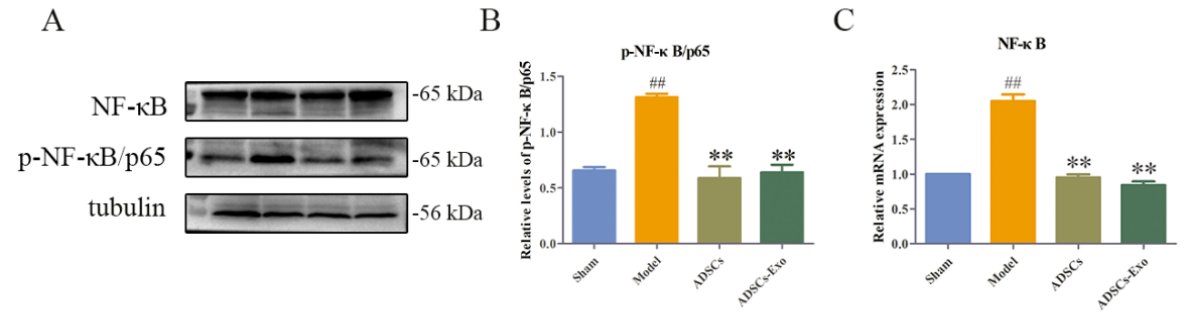
Figure 3. Western blot and qRT-PCR analysis of NF- κB -related protein and gene expression in the liver. Western blot analysis of p-NF- κB ( A ). Quantification of p-NF- κB ( B ). mRNA level of NF- κB in the liver in different groups ( C ). The data are expressed as mean ± SD. ## p < 0.01, versus the Sham group. ** p < 0.01, versus the Model group.